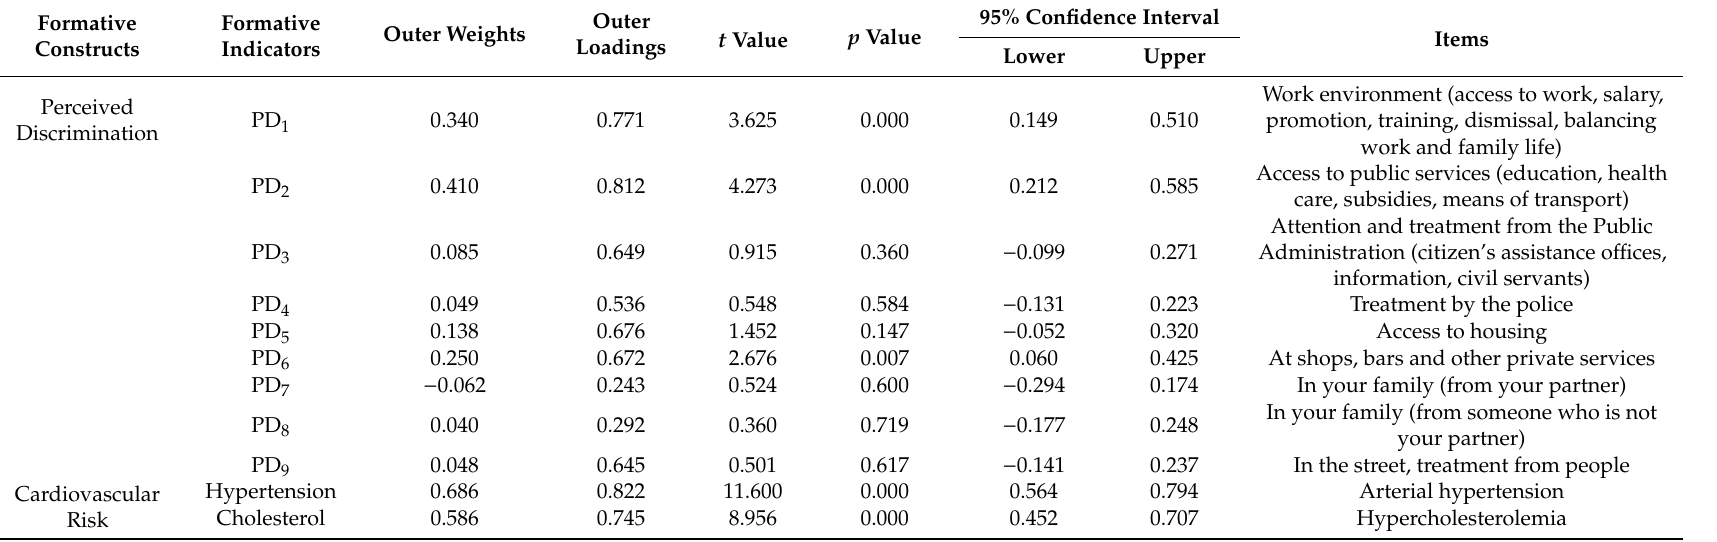
Table 2. Formative constructs outer weights significance testing results of perceived discrimination and cardiovascular